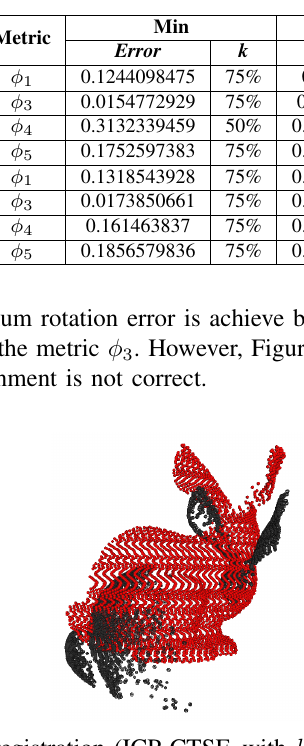
90 ◦ - 180 ◦ . TABLE IV: Best two methods, with minimum and maximum errors computed by each metric for the alignment 90 ◦